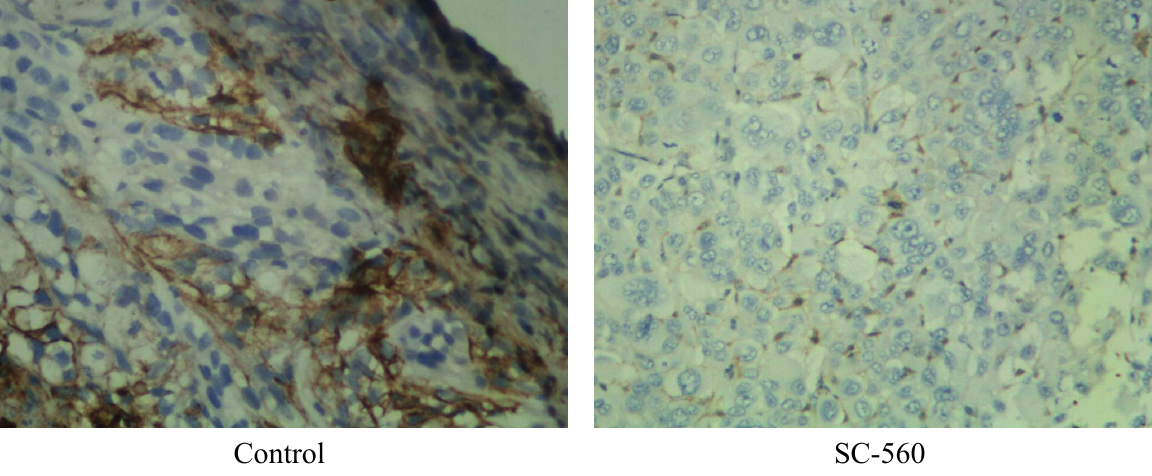
Figure 3. Effects of SC-560 on angiogenesis in SKOV-3 xenograft tumors. Representative pictures of CD34 immunohistochemical staining of tumors. Magnification is 100×.